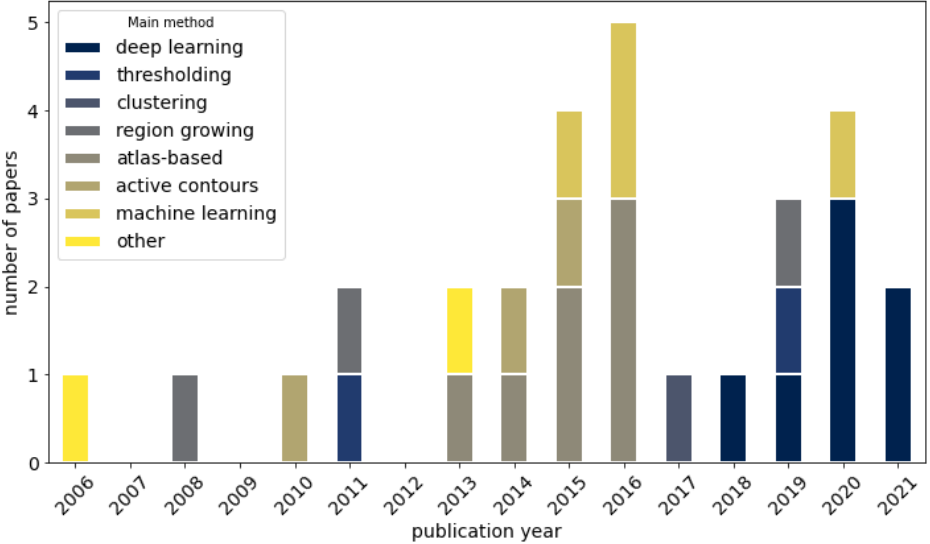
Figure 2. A summary of paper frequency and used